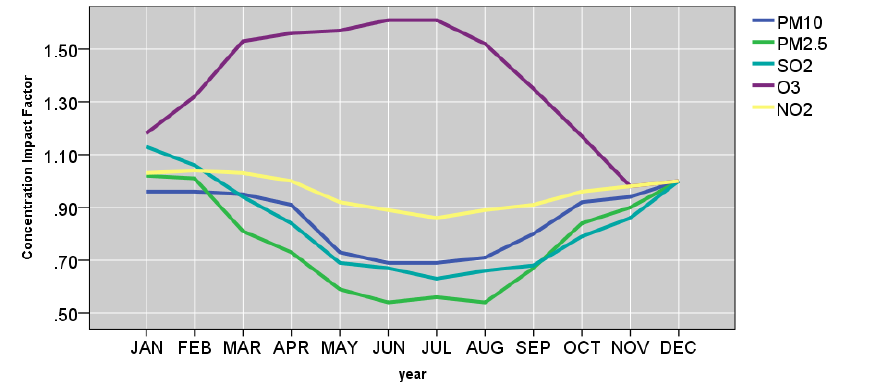
Figure 10. Monthly concentration impact